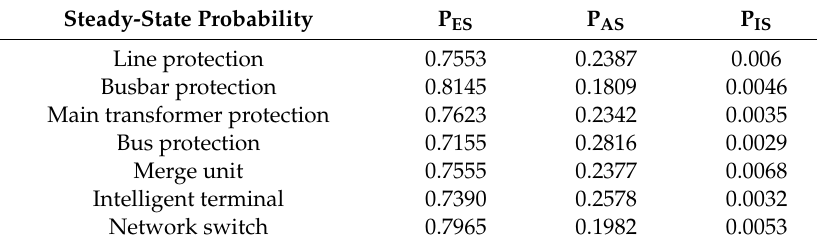
Table 4. Steady state probability of protection